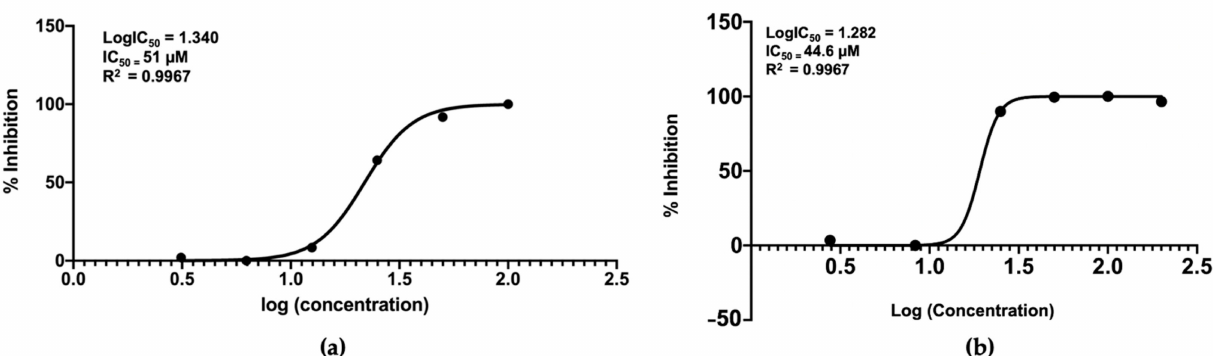
Figure 10. Inhibitory activity of nornidulin against Pf MQO ( a ) and proliferation of P. falciparum 3D7 cell in vitro, using p LDH assay method ( b ). The graph was drawn using GraphPad Prism V8 software.